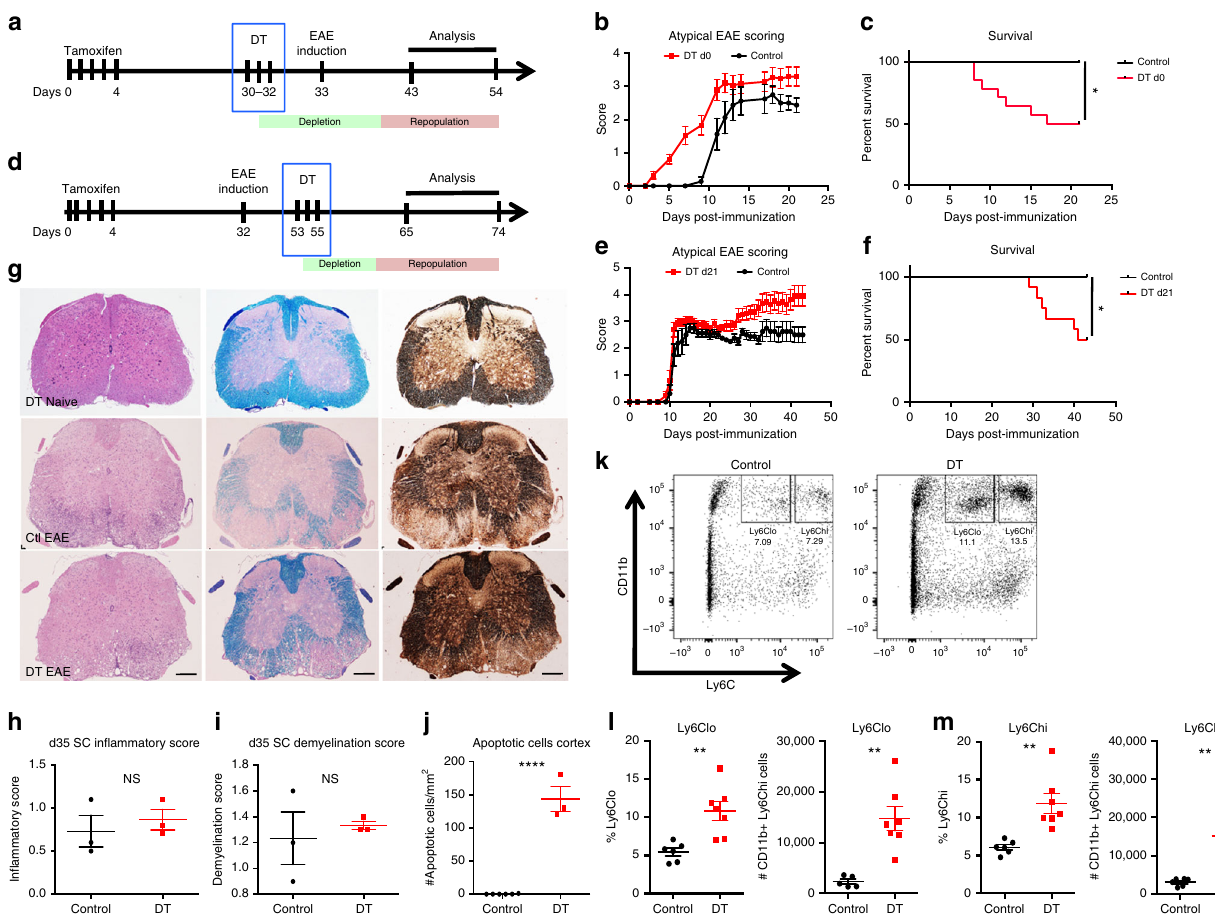
Fig. 6 Impact of microglia ablation on experimental autoimmune encephelomyelitis. a Schematic of microglia depletion before MOG/CFA-induced EAE. In this experimental paradigm, microglia are depleted preceding immunization. b Atypical EAE disease course and c mortality of microglia-depleted mice (red) compared to littermate control mice (black) ( n = 9 – 13 mice per group). d Schematic of microglia depletion at d21 post induction of MOG/CFA- induced EAE. In this experimental paradigm, microglia are depleted during the initial phase and in fl ammatory peak in EAE. e Atypical EAE disease course and f mortality of microglia-depleted mice (red) compared to littermate control mice (black) ( n = 9 – 15 mice per group). g Representative IHC of H&E, Luxol Fast Blue and Silver staining in spinal cord (SC) of naive d10 microglia-depleted mice, d35 EAE from control and mice with microglia ablated at d21 post-EAE induction showing similar EAE-related pathology of in fl ammation, demyelination and axonal loss between control and microglia-depleted animals. Scale bar = 200 μ m. h , i Quanti fi cation of in fl ammatory score ( h ) and demyelination score ( i ) of SCs at d35 post EAE induction. j Dot plot of number of apoptotic cells per mm 2 in somatosensory cortex at d35 EAE. Representative experiment of two independent experiments. k Dot plot of CD11b + Ly6 lo and CD11b + Ly6C hi in fi ltrating monocytes in the brain at d35 EAE. l , m Quanti fi cation of percentage and cell number of CD11b + Ly6C lo ( l ) and CD11b + Ly6C hi ( m ) from control and microglia-depleted EAE mice. Error bars depict SEM and n = 5 – 7 mice per group; **** p < 0.0001, *** p < 0.001, ** p <